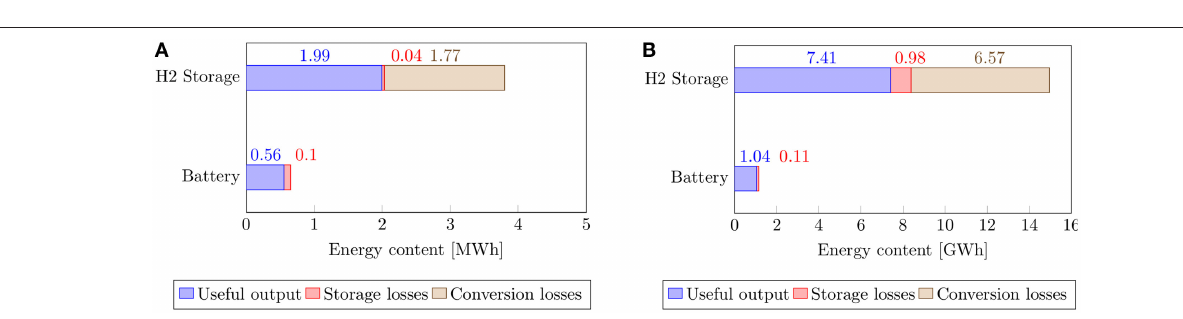
FIGURE 5 | Results of the optimization of the design of the system. (A) Off-grid dwelling, (B) Cruise ship.